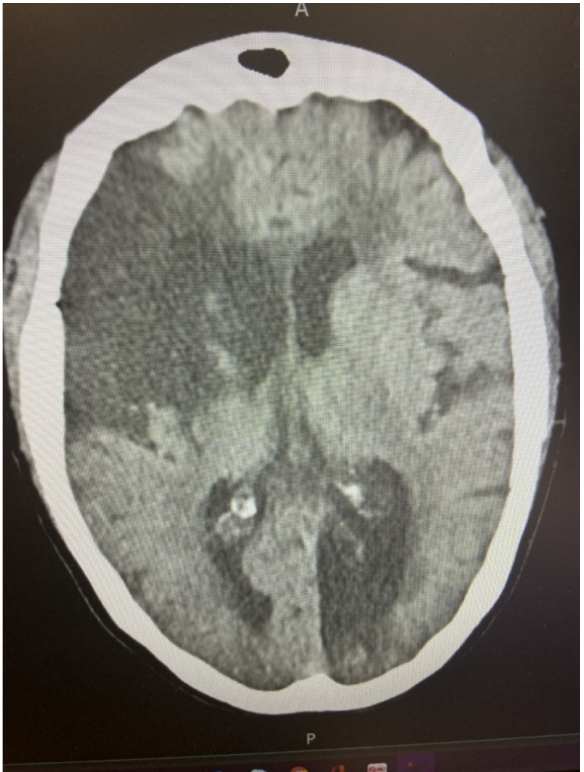
Figure 1. The Potential Effects of Atrial Fibrillation on the Cerebral Circulation. A = anterior, P =